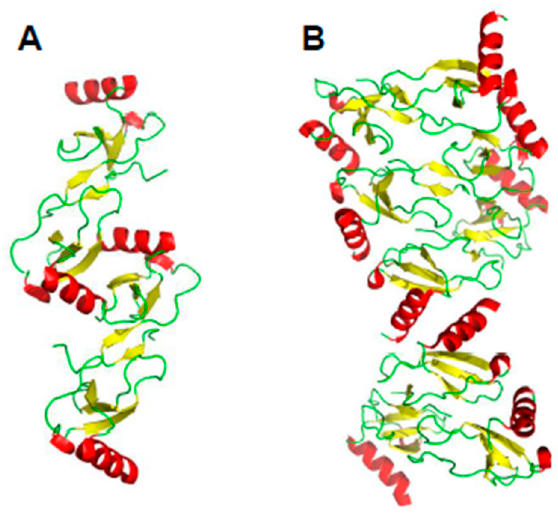
Figure 3. Higher-order oligomer structures of CCL5. ( A ) Proposed oligomer structure of CCL5 deduced from analysis of NMR, MS, and SAXS data (PDB access code: 2L9H, [15]; ( B ) Modeled oligomer structure of CCL3 (PDB access code: 5L2U, [17]) is shown to illustrate how a CC-type dimer could associate in a somewhat different fashion into a higher order oligomer. C-terminal helices are colored red; β -strands are colored yellow, and aperiodic sequences/loops are colored green.